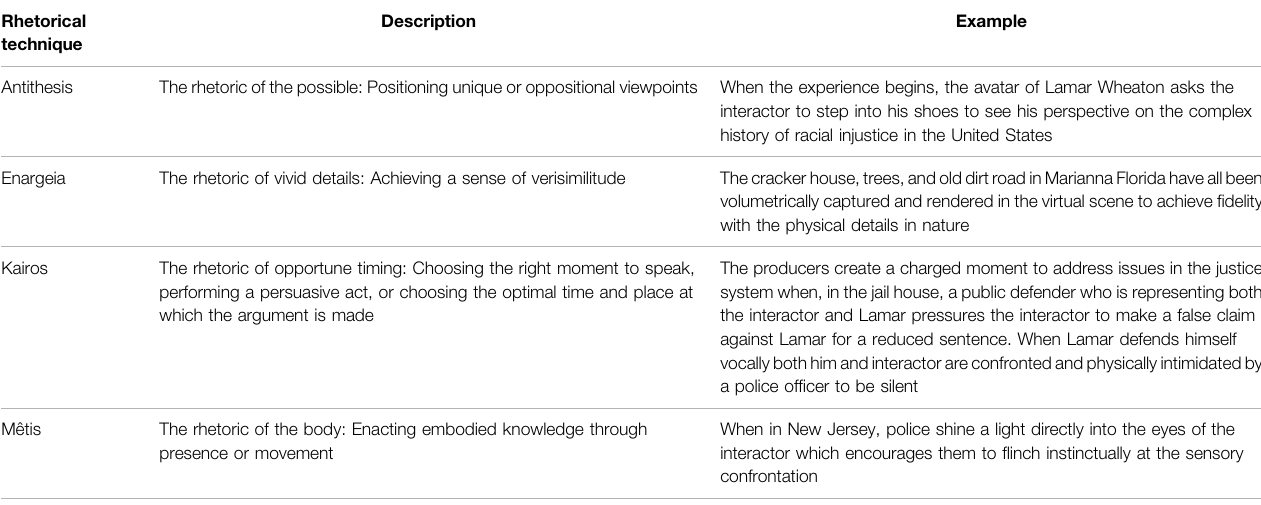
TABLE 1 | An explanation of the rhetorical tactics used in the